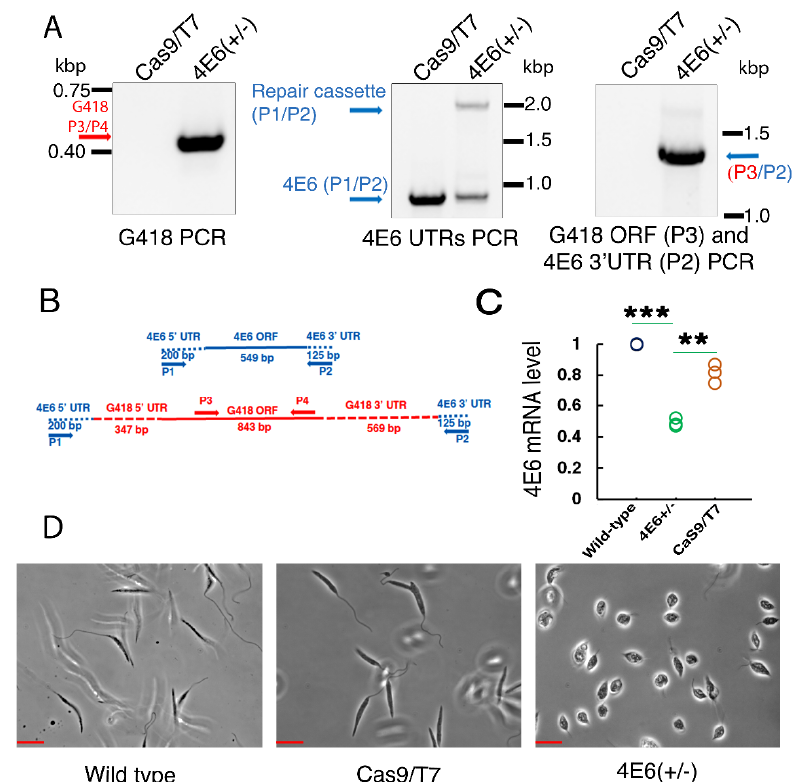
Figure 7. CRISPR-Cas9 mediated hemizygous deletion of LeishIF4E-6 affects cell morphology ( A ) Diagnostic PCR was performed to confirm the deletion of a single allele of LeishIF4E-6. Genomic DNA was extracted from L . mexicana Cas9/T7 cells and the LeishIF4E-6(+/ − ) mutant. PCR was performed using different combinations of primers derived from the G418 ORF (Forward) and Reverse (P3/P4, middle panel), LeishIF4E-6 5 ′ UTR (Forward) and 3 ′ UTR (Reverse, P1/P2 –left panel); and a primer set derived from the G418 resistance gene (forward) and the 3 ′ UTR (Reverse, P3/P2); ( B ) a schematic representation of the LeishIF4E-6 locus and the primers used (represented by arrows). The PCR was applied to test the presence or absence of the LeishIF4E-6 gene and the G418 resistance marker. Primers derived from the LeishIF4E-6 UTRs are shown in blue and primers derived from the ORF of G418 are shown in red. ( C ) The relative decrease in the LeishIF4E-6 transcript levels in hemizygous LeishIF4E-6(+/ − ) mutant was determined by quantitative real-time PCR assay. The relative expression of the LeishIF4E-6 transcripts was calculated using a 2 −ΔΔ CT formula where endogenous control GAPDH was used as the normalizer. The values of three replicates were represented as a dot plot graph. The statistical analysis was carried out using GraphPad Prism 5 and significant differences were estimated by a non-parametric T-test using the paired t -test. Significant p -values were marked as follows: p -value < 0.01 (**) and p -value < 0.001 (***). ( D ) Mid-log phase (Day 2) promastigotes of WT, Cas9/T7 expressers, and LeishIF4E-6(+/ − ) cells were fixed with 2% paraformaldehyde and visualized by phase-contrast microscopy at 100x magnification. Wild-type, Cas9/T7 overexpressing cells showed normal promastigote morphology while LeishIF4E-6(+/ − ) were round swollen with reduced flagellar length. The red scale bar represents 10 µm.